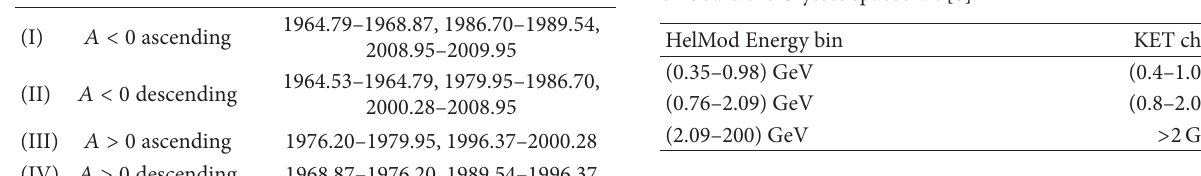
T 2: Kinetic energy bins (in GeV) selected with HelMod Code and the corresponding proton energy channel for KET instruments on board the Ulysses spacecra